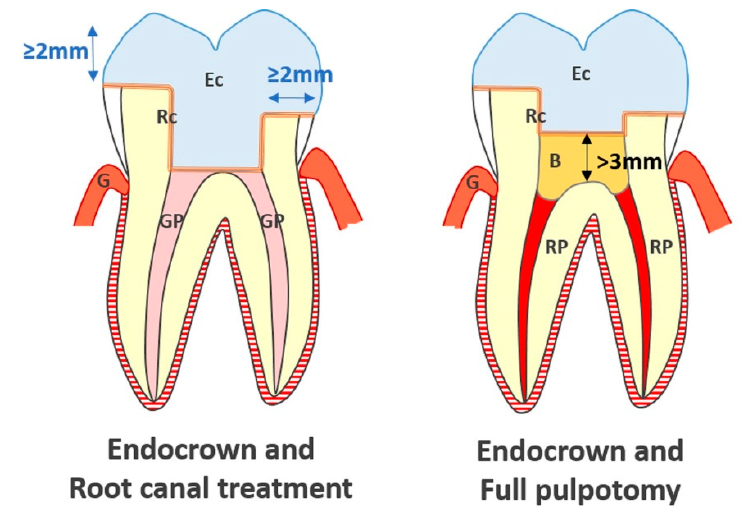
Figure 1. Schematic comparison of central anchorages of endocrowns carried out on teeth treated with